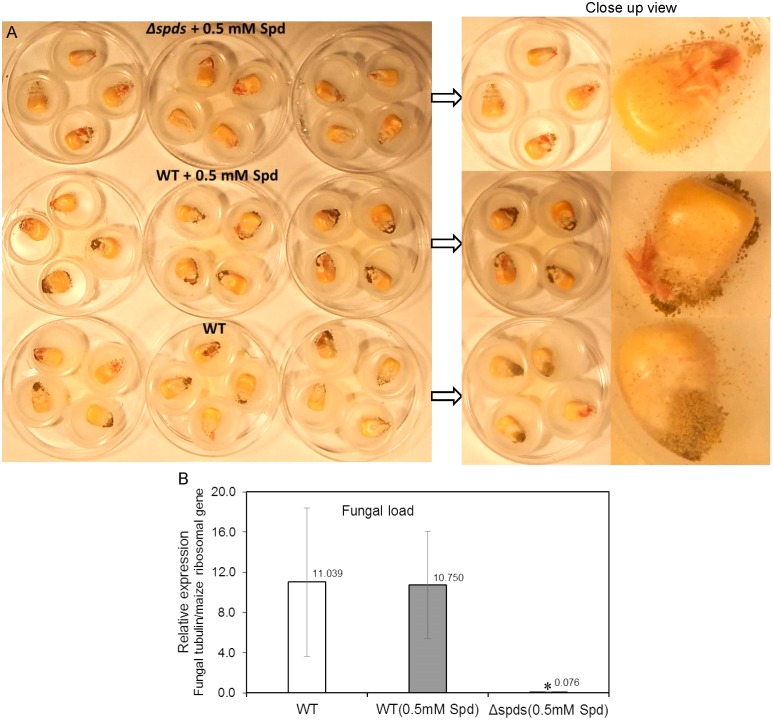
The CA14 Δspds mutant showing reduced pathogenicity during maize-A. flavus interaction. (A) Maize kernels at 8 days post-inoculation (dpi) were infected with either the CA14 WT or the Δspds mutant (post-growth on CZ solid medium, which may or may not have been supplemented with Spd, for 1 week prior to the kernel inoculation); (B) Estimation of fungal load in maize kernels at 8 dpi, infected with WT and Δspds CA14 strains. Fungal load was expressed as relative expression of the β-tubulin gene (AFLA_068620) to the maize ribosomal structural gene (used as housekeeping) GRMZM2G024838 (Shu et al., 2015). Data are Mean ± SE of 3–4 replicates, each replicate consists of 4–5 seeds; (∗P ≤ 0.10 between WT and treatment, Student’s t-test).